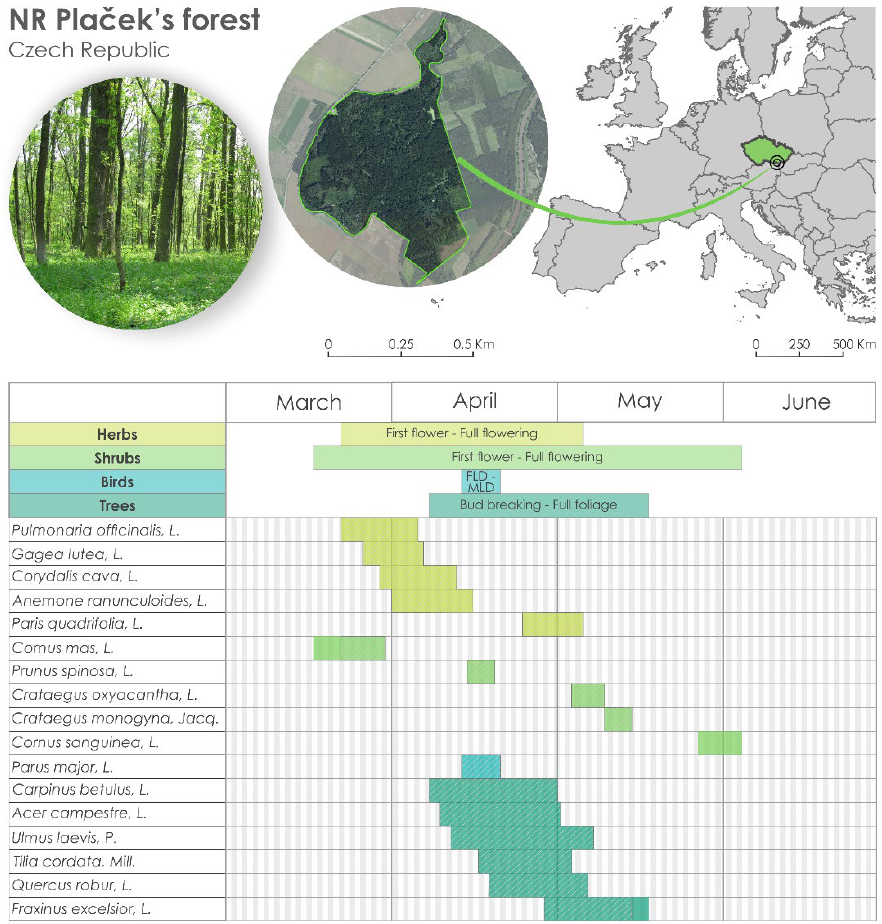
Figure 1. Location of the experimental site (Plaček´ Forest National Reserve) in the Czech Republic (upper part) and the table in the lower part with all species and mean dates of two phenological phases for each species. The hatching in the boxes indicates the phenological episodes that overlap among all others. FLD indicates the date when the first clutch in a given year was initiated at a given site. MLD indicates the mean initiation date of all first clutches in the population at each site in a given year.